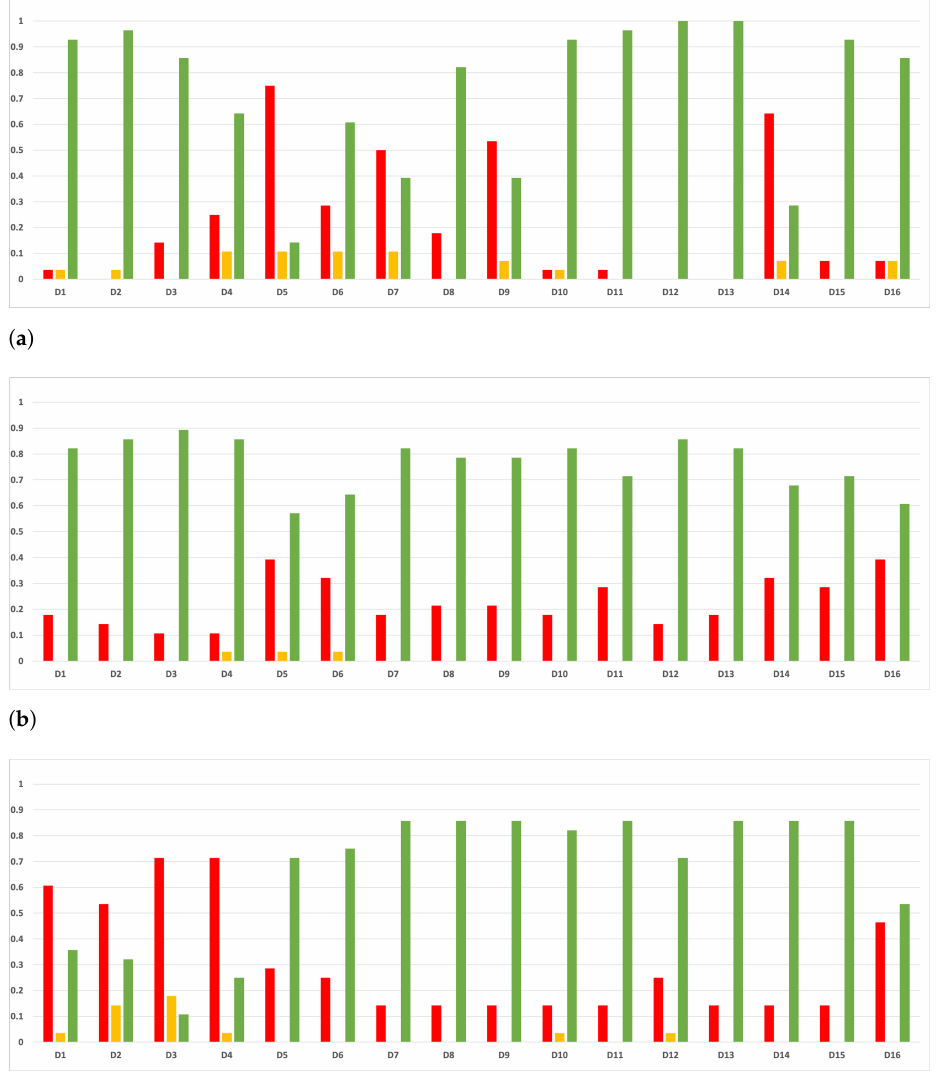
Figure 19. Consistency per dataset: rate of validity with the MCC and time complexity. ( a ) Rate of validity per dataset in RF. In axis X, the dataset. In axis Y, the rate of RHOASo for each class of validity. ( b ) Rate of validity per dataset in GB. In axis X, the dataset. In axis Y, the rate of RHOASo for each class of validity. ( c ) Rate of validity per dataset in MLP. In axis X, the dataset. In axis Y, the rate of RHOASo for each class of